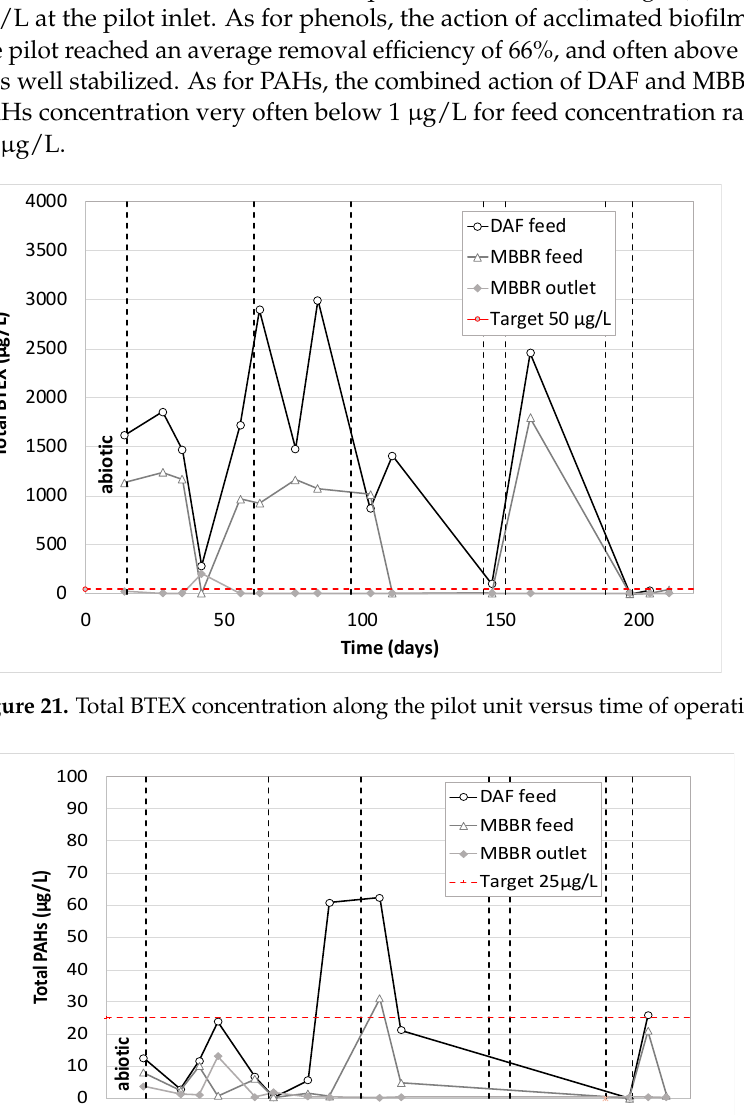
Figure 22. Total PAH concentration along the pilot unit versus time of operation.